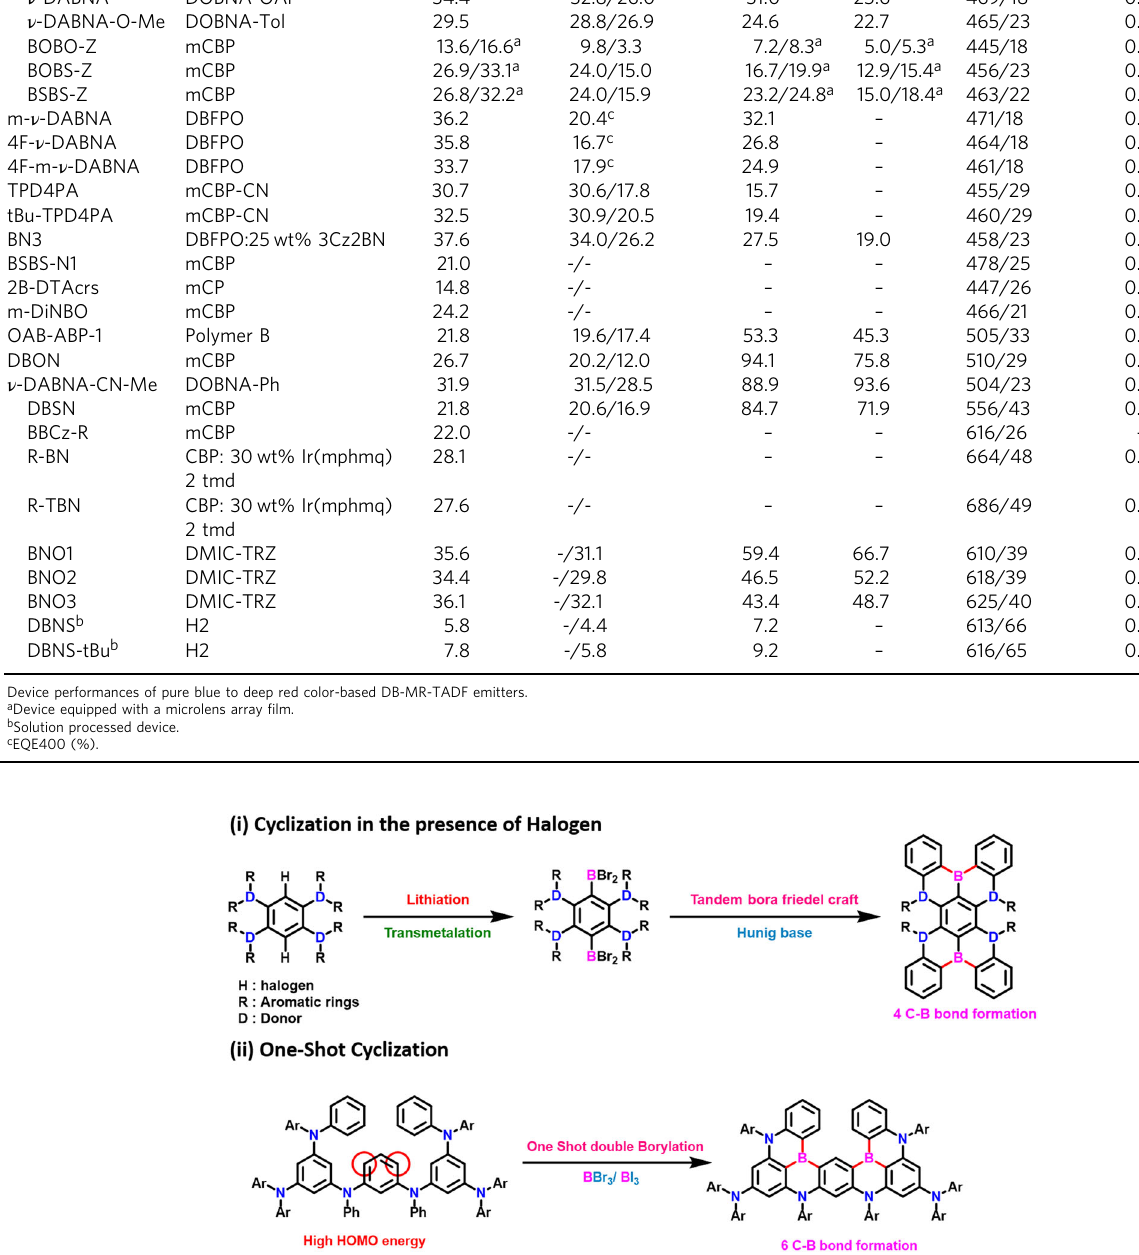
Fig. 6 Possible synthetic routes of double borylations. The synthetic pathways utilized for most of the DB-MR-TADF